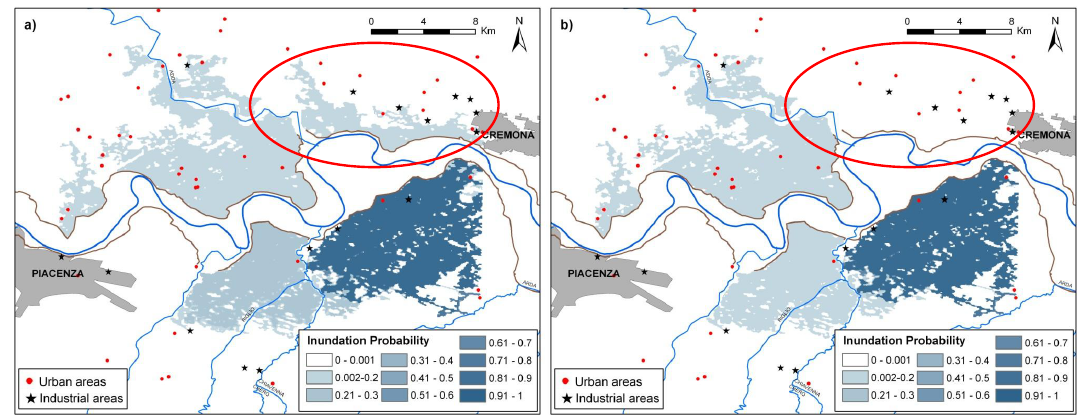
Fig. 9. Probabilistic flood hazard maps for the Tr200 event obtained with variable Traditional ( a : RandomT subset) and Constrained ( b : RandomC subset) rating